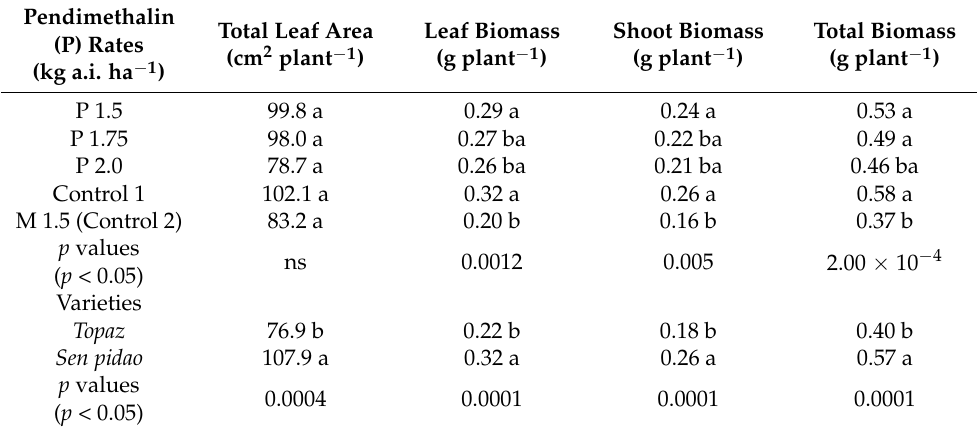
Table 3. Effect of pre-emergence herbicide and varieties on the growth of the transplanted rice